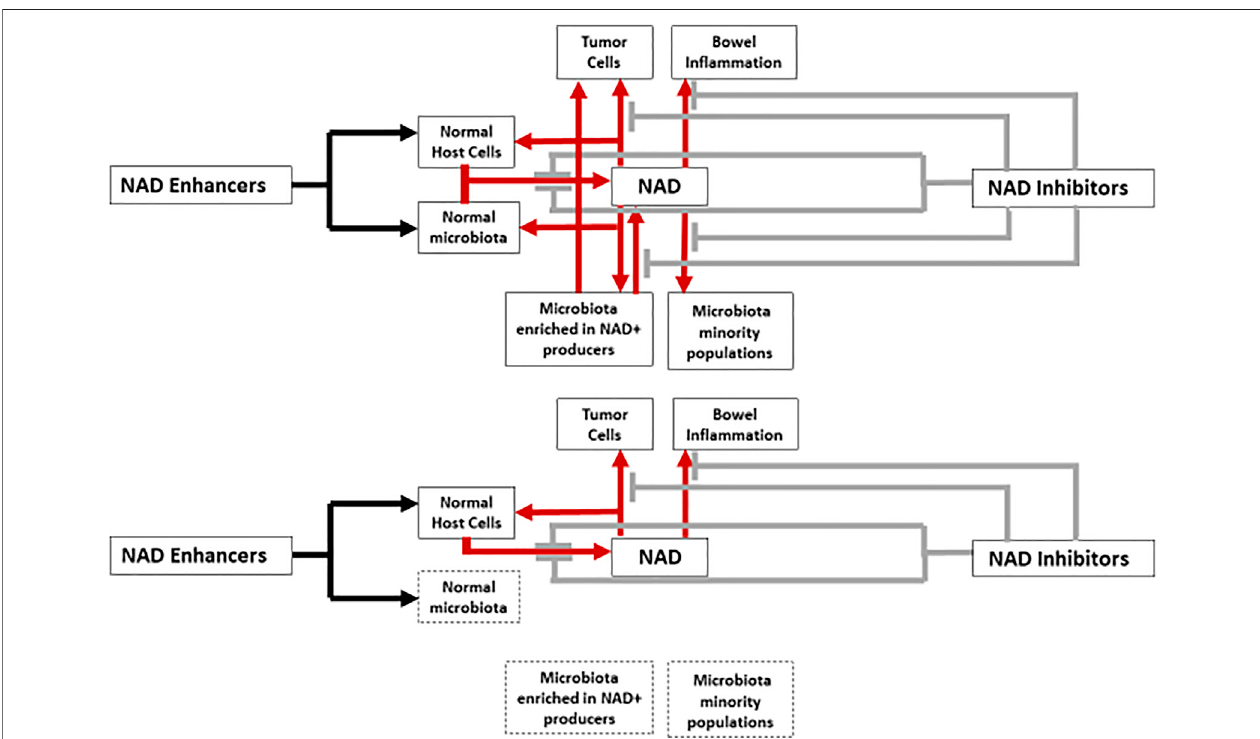
FIGURE 1 | Interactions between NAD metabolism enhancers, inhibitors, host cells and microbiota. Red arrows and grey brakes correspond to the increasing (boosting compounds) or decreasing (inhibitory compounds) effects on NAD levels, respectively. In the lower part of a fi gure the same schema is reproduced with the expected inhibitory effect of antibiotic therapy, reducing or eliminating the contribution of the microbiota on NAD metabolism (spotted boxes).